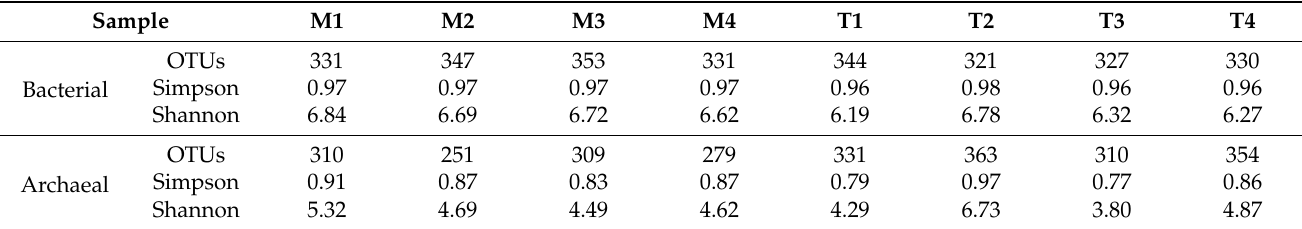
Table 4. Microbial diversity indexes of the microbial